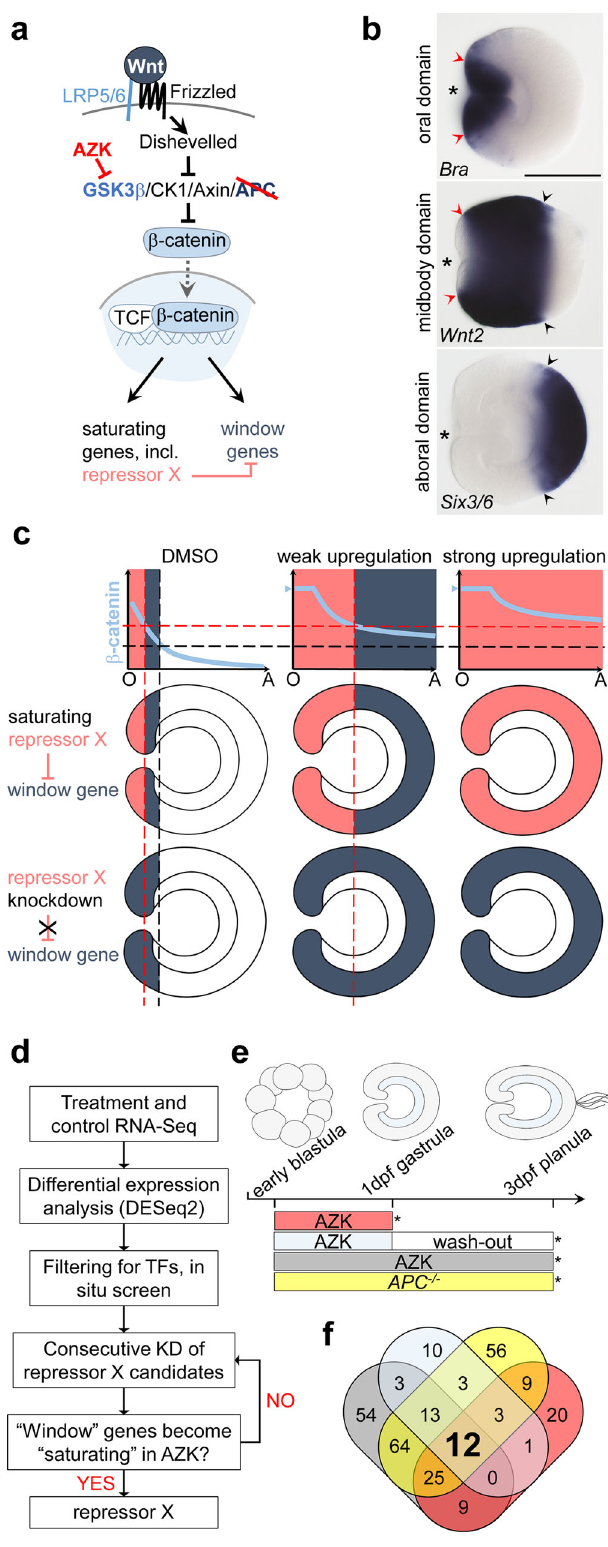
Repressor X is not a single gene but a unit of four genes . The area of strong Bra expression overlaps with the Wnt1 expression domain and abuts the Wnt2 expression domain (Fig. 2). Upon